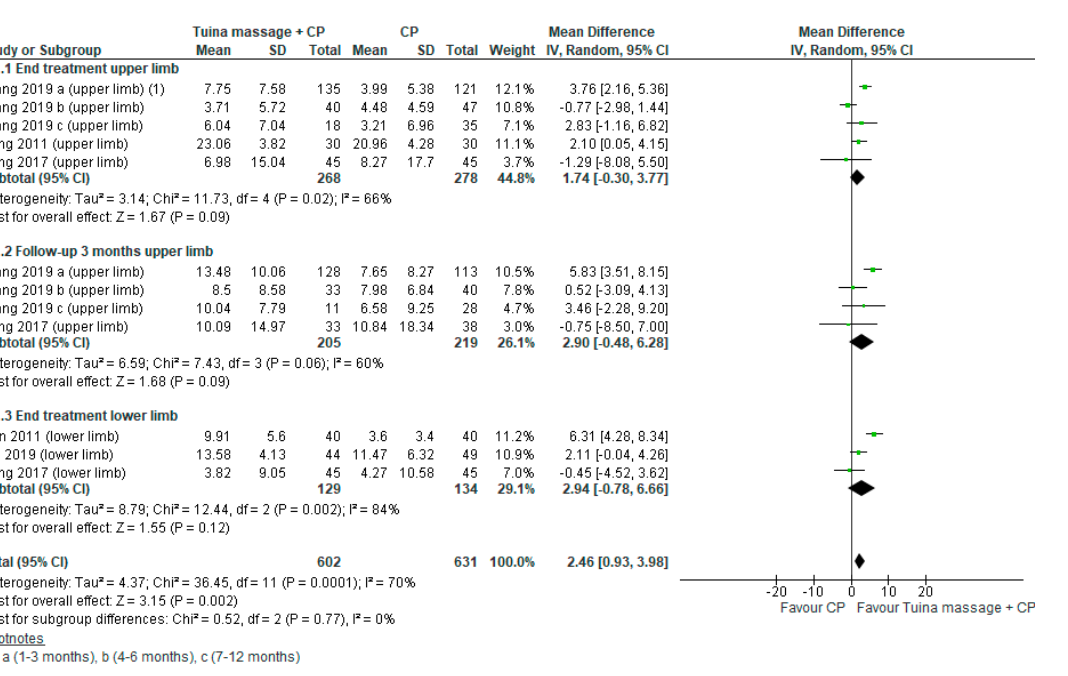
Figure 3. Forest plot of comparison Tuina massage plus conventional physiotherapy (CP) versus CP for upper limb motor function in subacute stage ( ≤ 3 months) evaluated by Fugl Meyer Assessment For the second comparison a meta-analysis was performed. The MD was 1.03; (95% CI from − 0.03 to 2.03, p = 0.04, I 2 = 0%) in the follow up (Figure 4).